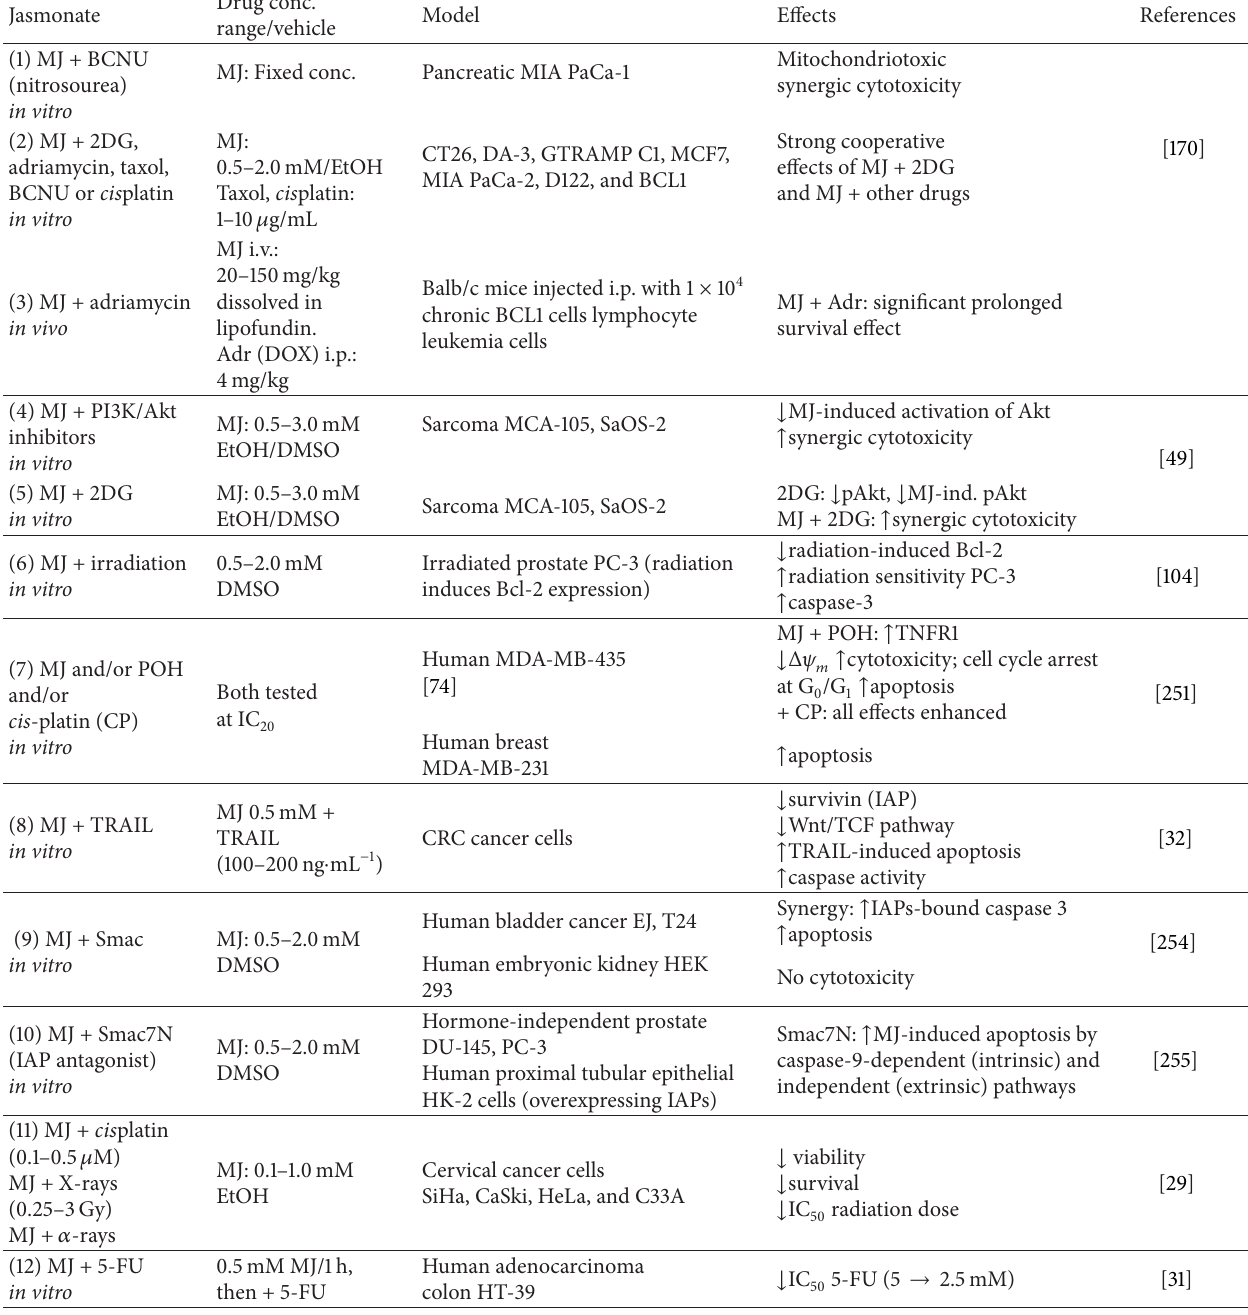
Table 3: Effect in vitro and in vivo of methyl jasmonate (MJ) combined with other anticancer agents. Drug Jasmonate